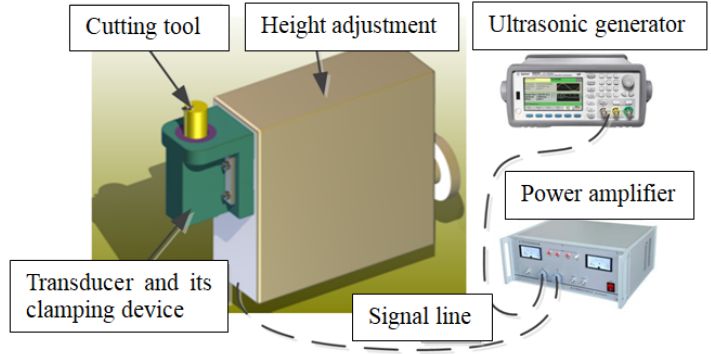
Figure 1. Schematic diagram of the ultrasonic vibration cutting system used in this experiment.